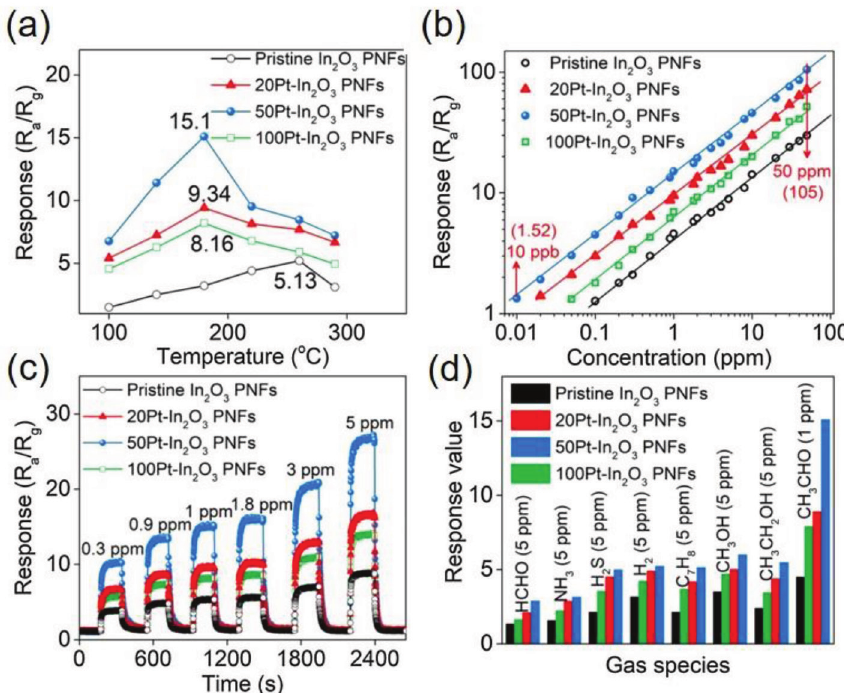
Figure 7: (a) The sensors’ response to 1 ppm acetone versus the working temperature, (b) the dynamic response curves in the concentration range of 0.3-5 ppm, (c) the linear relationship between response and acetone concentrations, (d) the selectivity tests for the pristine In PNFs ‡ and 20/50/100 Pt−In O PNFs sensors. ‡ Porous nanofibers. Reprinted with permission from Ref. [126]. Copyright 2019, 2 3